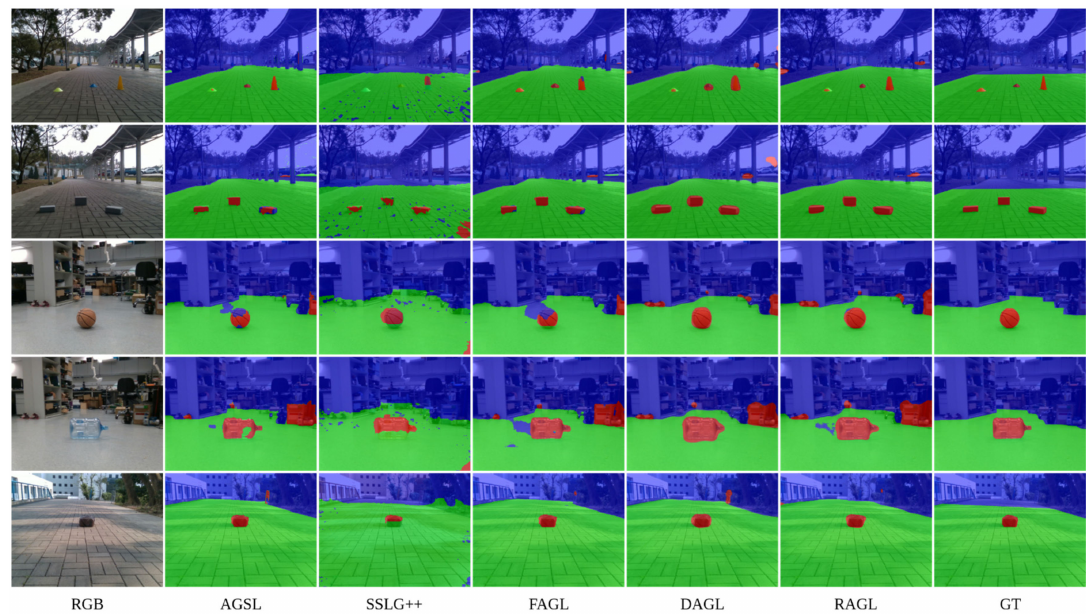
Figure 5. The comparison of the segmentation results between GT (manual labels), AGSL labels, SSLG++ labels, FuseNet trained on AGSL labels (FAGL), Depth-aware CNN trained on AGSL labels (DAGL), RTFNet trained on AGSL labels (RAGL), and manual labels (GT). The blue area denotes the unknown area, the green area denotes the drivable area, and the red area denotes road anomalies. The figure is best viewed in